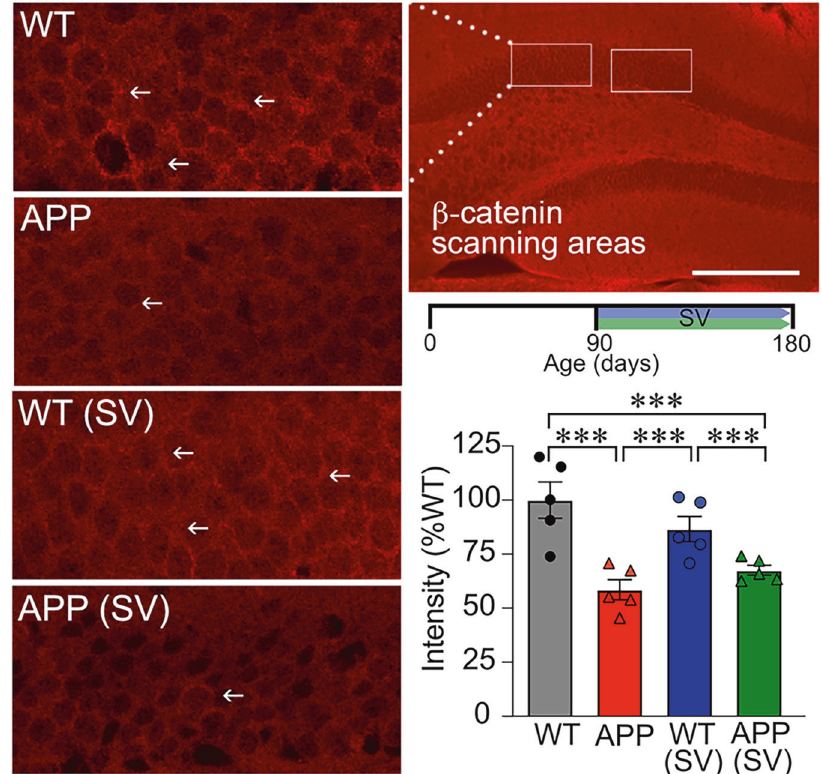
Fig. 6 SV did not affect β -catenin in the dentate gyrus granule cell layer. β -catenin immuno fl uorescence staining in the mouse hippocampus was quanti fi ed in the granule cell layer (white boxes in right top panel) shown on the confocal images (left panels). Fine β -catenin-immunostained punctate structures were localized in the neuropil surrounding the granule cells in WT controls (arrows, left panels); structures that were signi fi cantly less intensely labeled in APP mice. SV treatment (timeline shown on top of bar graph) had no effect as analyzed by MetaMorph software (bottom at right panel). *** p < 0.001, using two-way ANOVA followed by Newman – Keuls post-hoc test. Bar = 200